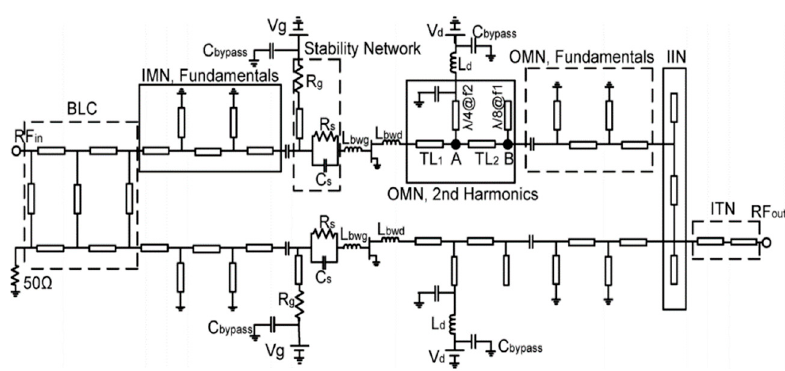
Figure 6. Dual-band Doherty power amplifier (DPA) schematic designed by [25].